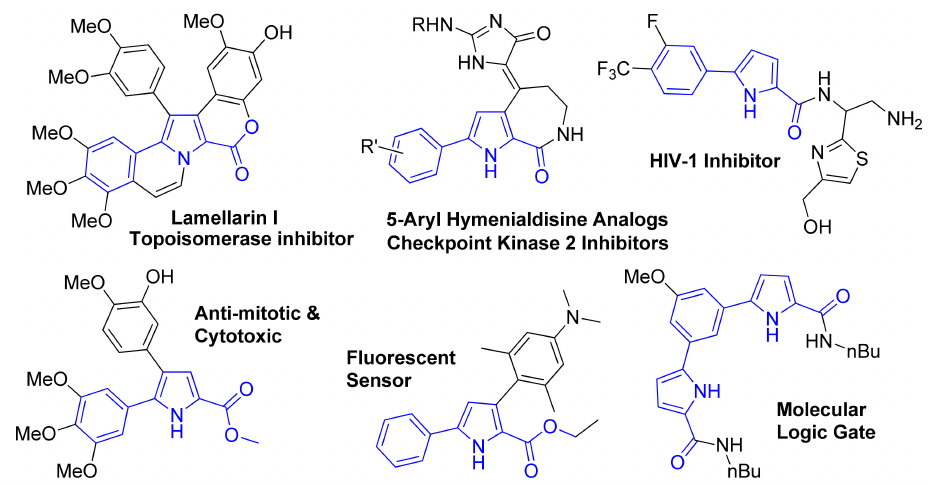
Figure 1. Selected examples of 5-arylpyrrole-2-carboxylate based natural products, biologically active compounds, and organic materials.